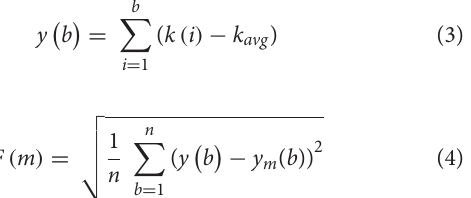
TABLE 1 | Stomatognathic motor conditions of the three groups, JAW, TON, and HAB. JAW: instructed, controlled submaximal jaw clenching with a 75N force—activity of the masticatory muscles during simultaneous occlusal